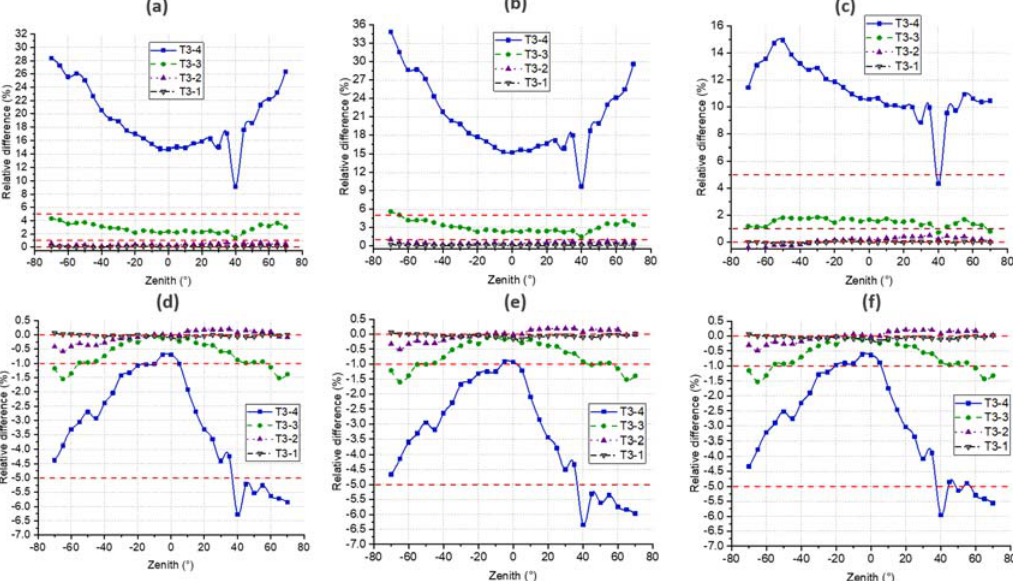
Figure 18. Relative difference for the last stage, ( a ) 650nm, ( b ) 670 nm, ( c ) 700 nm, ( d ) 750 nm, ( e ) 800 nm, and ( f ) 850 nm. The dashed lines in red represent the relative difference of 1% and 5%.